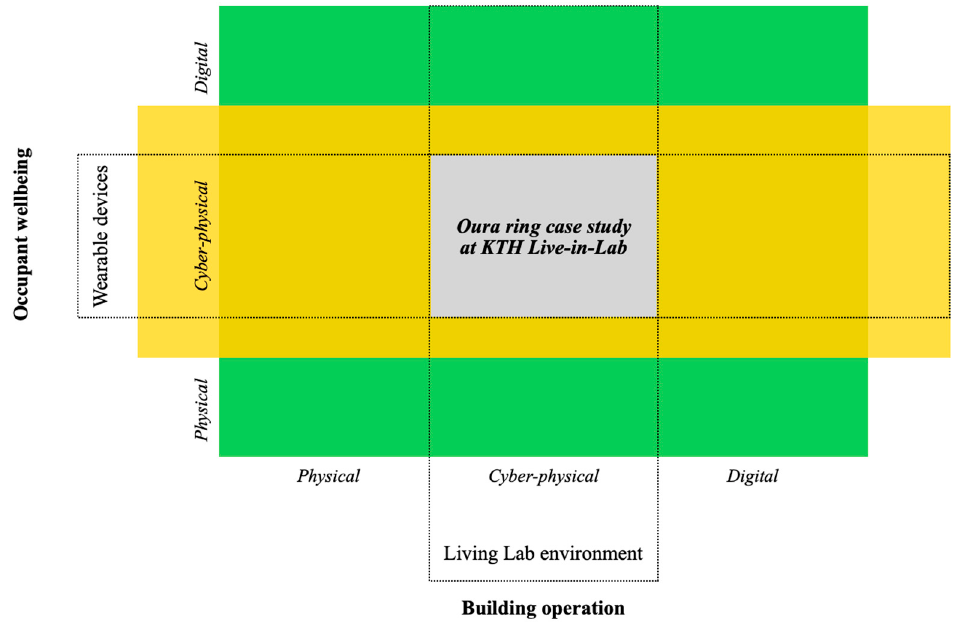
Figure 1. Research domain intersection: occupant wellbeing and building operation.